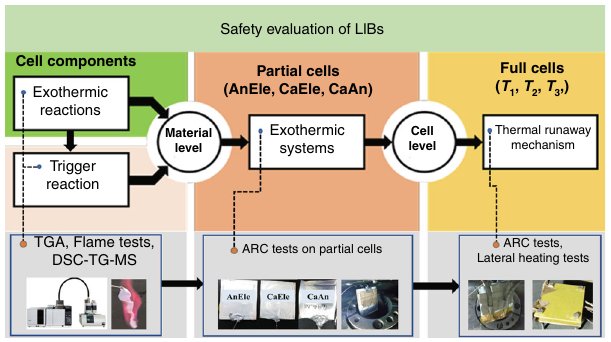
Fig. 7 Safety evaluation of LIBs. Characterization of battery safety at the cell and material levels and the corresponding